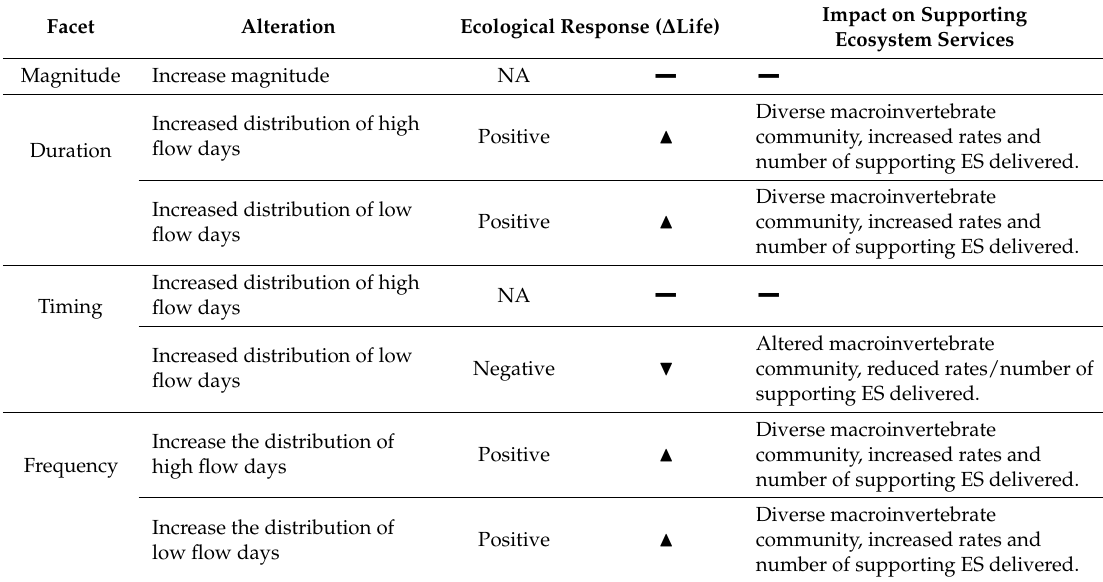
Table 5. Predicted hydroecological response to alteration of the facets of the flow regime (based on the hydroecological model). Increases detailed; decreases have inverse effects. The symbols ▲ / ▼ indicates changes observed through inputting adjusted flow magnitudes into the hydroecological model.